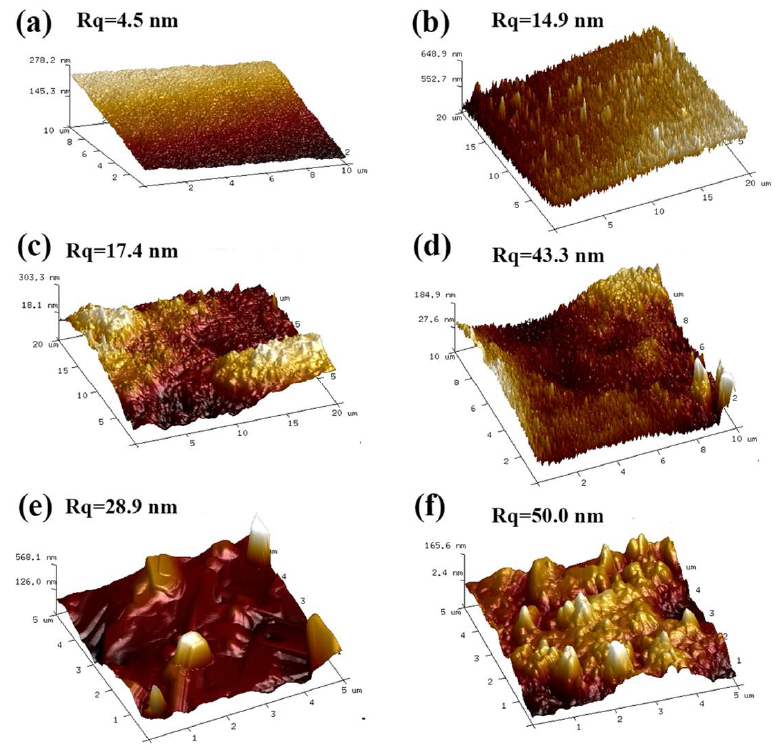
Figure 6. AFM images of different films before and after air plasma treatment. ( a ) PVA film; ( b ) PPVA-3 film; ( c ) CNC/PVA film; ( d ) CNC/PPVA-3 film; ( e ) CNC/OA/PVA film; ( f ) CNC/OA/PPVA-3 film.